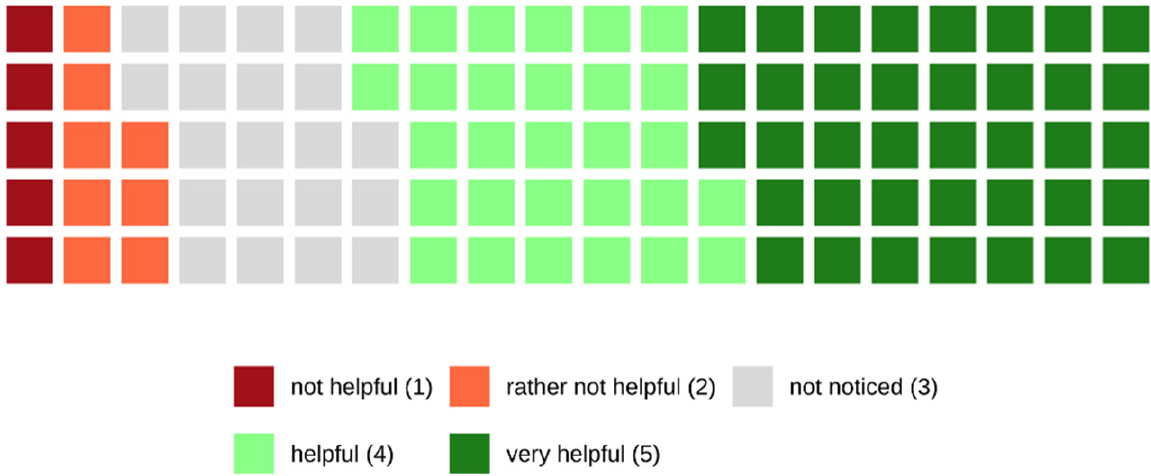
Figure 11. Waffle chart showing the answers regarding the helpfulness of the visual patient instruc- tions. Most patients (67.0%) found the visual patient instructions helpful or very